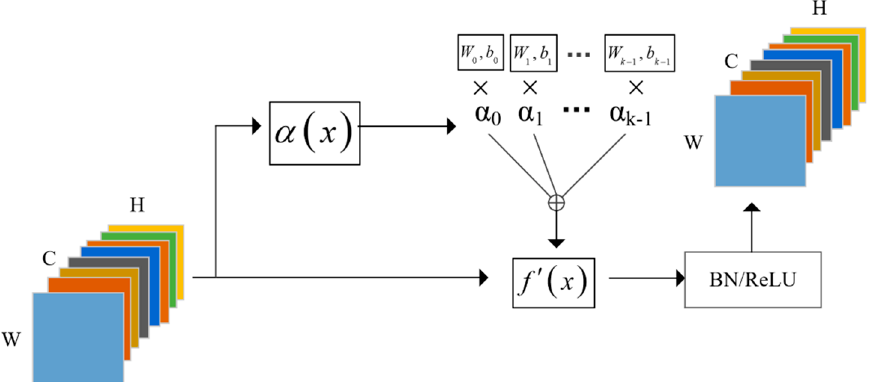
Figure 1. Model of dynamic convolutional network. In the figure, C is the channel size of feature maps; H and W are the size of spatial information; α ( x ) is the Squeeze-and-Excitation (SE) attention module; f (cid:48) ( x ) is the dynamic perceptron core; and W i , b i is the dynamic core.